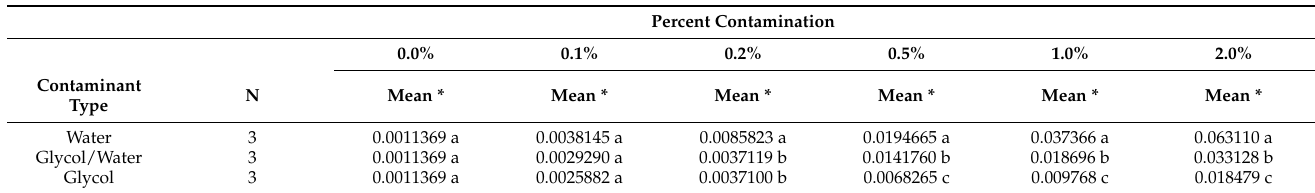
Table 2. Summary of the differences in contamination levels of the mean absorbance in the 3150–3500 cm − 1 wavenumber